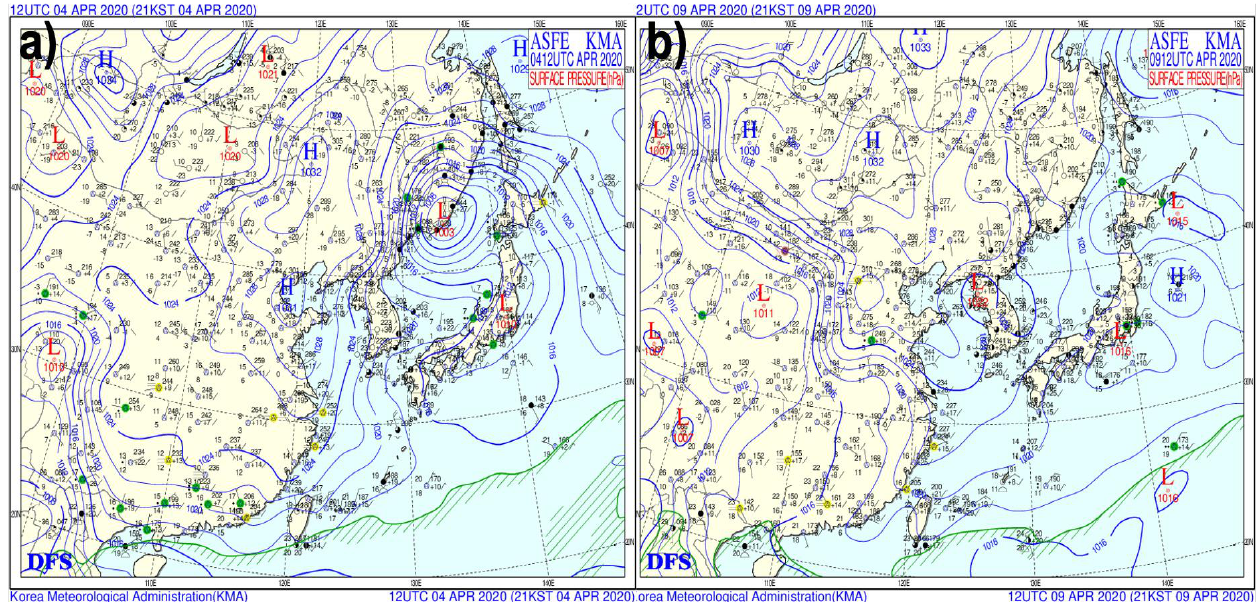
Figure 4. The 12 UTC (21 LST) surface weather chart for ( a ) 4 April 2020 and ( b ) 9 April 2020.